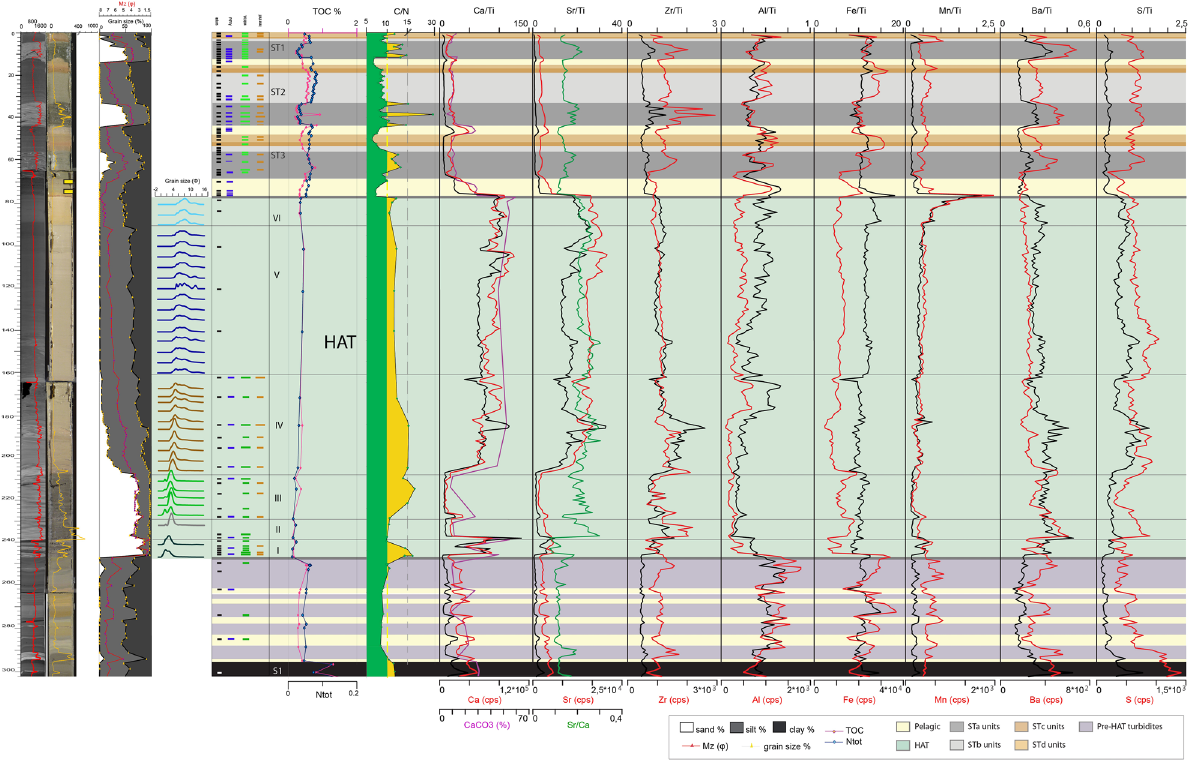
Figure 3. Log of core CALA-04. From left to right: CAT scan with HU (Hounsfield Unit) in red color, photograph with high-resolution magnetic susceptibility in yellow, grain size % with mean diameter in magenta, grain size modes in different colours for each sediment unit within the HAT, benthic foraminifera assemblages, sedimentary facies for ST1, ST2 and ST3 in different colors 4 , subdivision in individual HAT units (I-VI) in green and pelagic units identified by different colors, organic carbon data (TOC%, N tot , and C/N: green areas if C/N < 10, yellow areas if C/N > 10) and XRF data plot along the study sample. Yellow rectangle on the CAT scan image, represents 14 C dated samples (SM1). Benthic foraminiferal assemblages are grouped in three different classes: blue = abyssal species (mainly A. tubulosa); green = wide bathymetric ranges; brown = inner shelf (see Table 2, SM6 and SM7 for more details). Thin sample rectangles represent 0,5 cm thick samples. Thick sample rectangles represent 1 cm thick samples. Small coloured rectangles = rare specimens: < 25 specimens in 0.03 g of sample; large coloured rectangles = common specimens: > 25 specimens in 0.03 g of sample (see Table 2 for details on the bathymetric distribution). Identified seismo-turbidites (ST1, ST2 and ST3) with individual units (a, b, c and d) are